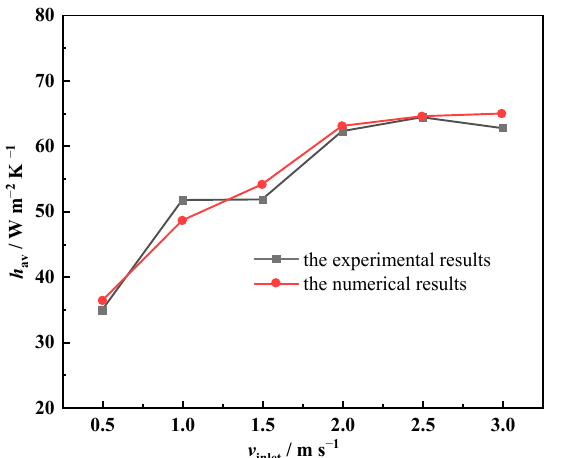
Figure 4. Model validation. Numerical results compared with the experimental results of research [48].